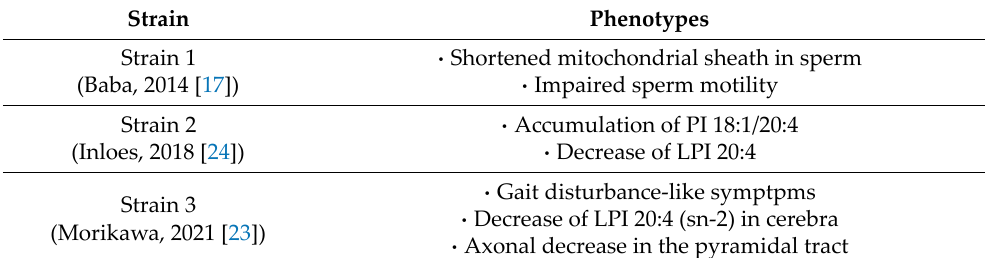
Table 1. Observed phenotypes of three different Ddhd1 knockout mice